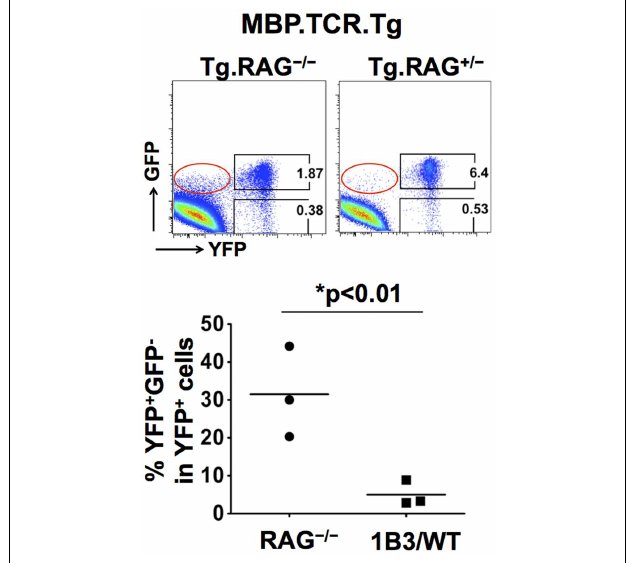
FIGURE 2 | Stability ofTreg subsets in MBP.TCR.Tg 1B3 mice using lineage reporter system .The MBP.TCR.Tg mouse when crossed onto RAG − / − background lacks tTregs but generates pTregs in the periphery highlighted by red box (GFP + YFP − subset).The FACS plots depicting expression of GFP andYFP by CD4 + T cells from LNs of 3- to 4-week-old MBP.TCR.Tg.RAG − / − .Foxp3-Cre × R26-YFP or MBP.TCR.Tg.RAG + / − . Foxp3-Cre × R26-YFP mice are shown. In the current gating strategy, GFP + YFP + population represents the stableTreg subset whereas GFP − YFP + gate represents unstableTregs, which previously expressed Foxp3. Cells gated on CD4 + T cells are shown and numbers around the outlined areas indicate percent. Graph on bottom shows the frequency of GFP − YFP + amongYFP + cells with each symbol representing an individual mouse and bars representing mean values for each